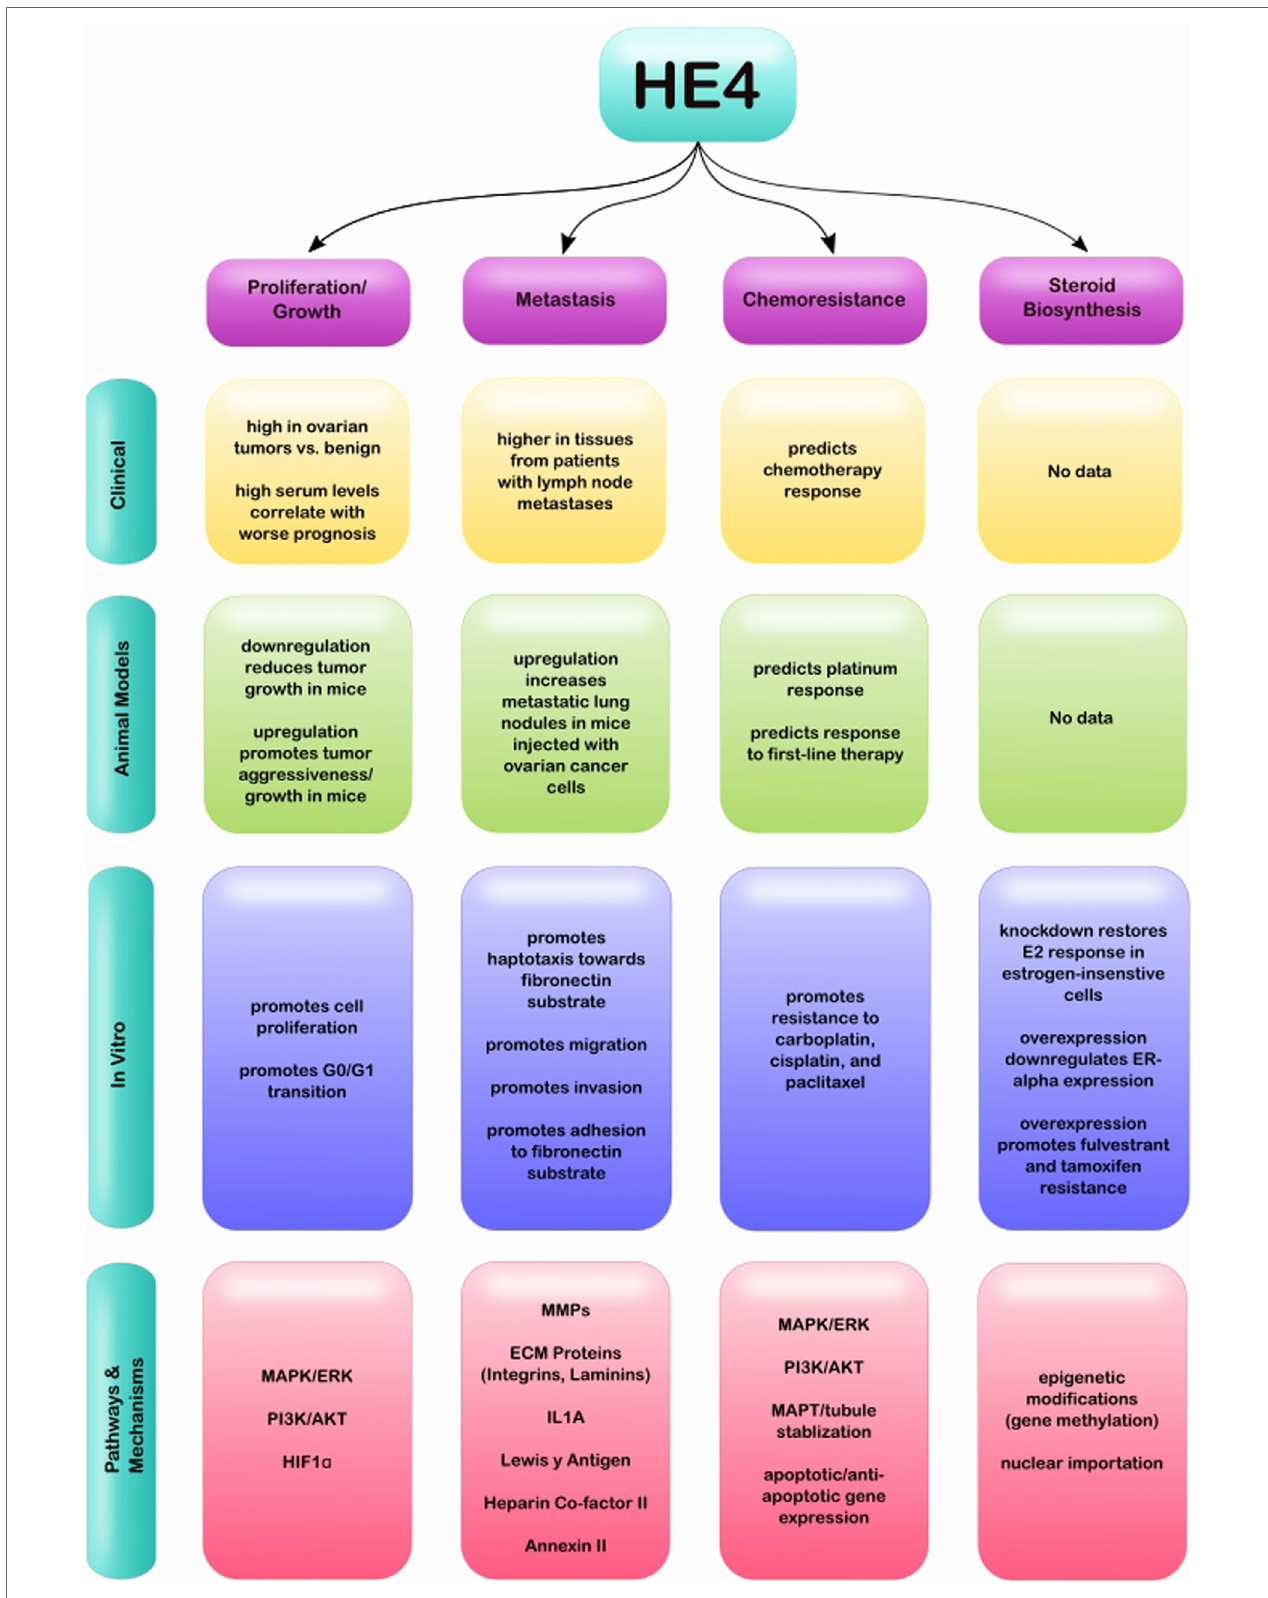
FiGURe 1 | Graphical representation of clinical, in vivo and in vitro studies completed relating to HE4 and EOC, as well as associated pathways and mechanisms.